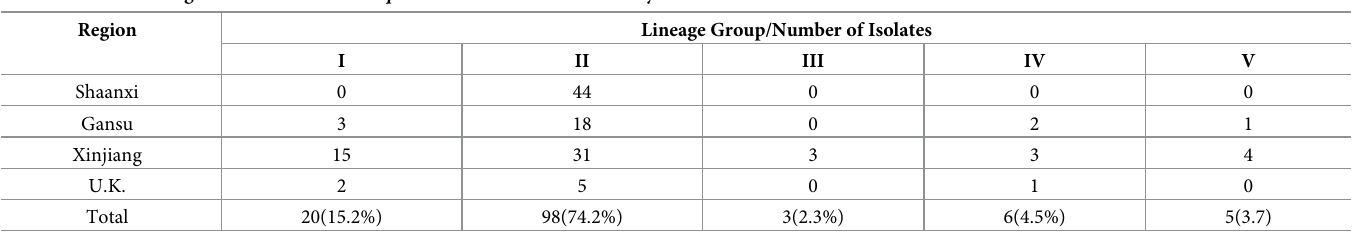
Table 2. Genetic lineages of 132 Venturia inaequalis isolates at a 0.76 similarity coefficient. Region